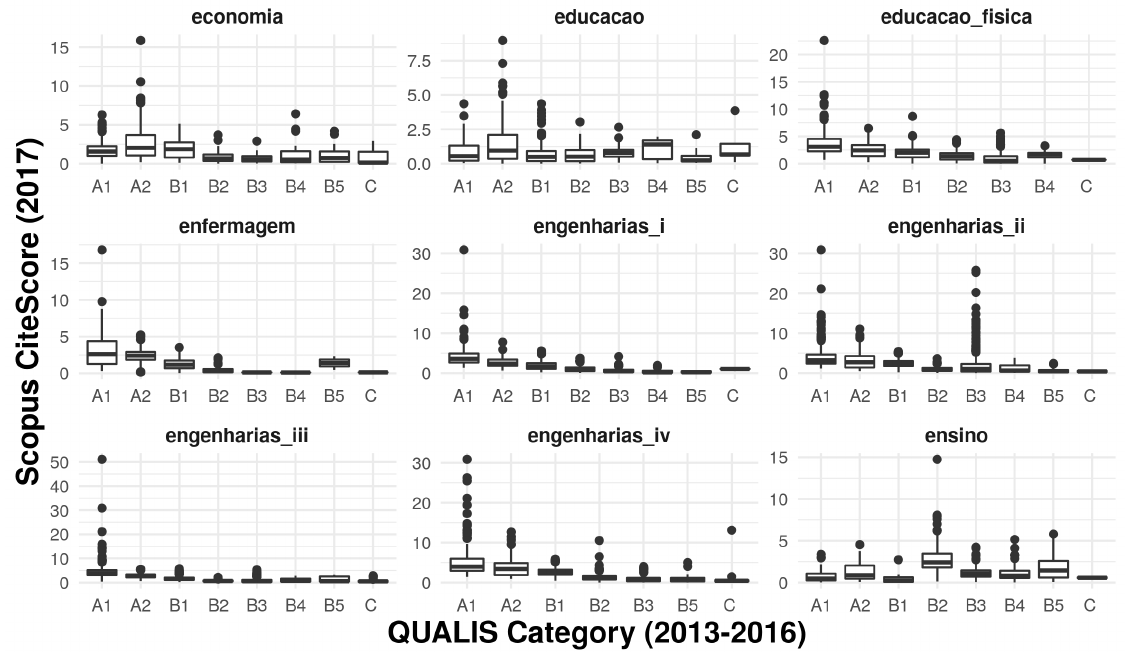
Figure 5. Scopus CiteScore variation across QUALIS categories in nine subject area. Original QUALIS subject area names are shown (as written in their respective classification sheets) but their English translation can be found in Table SI.